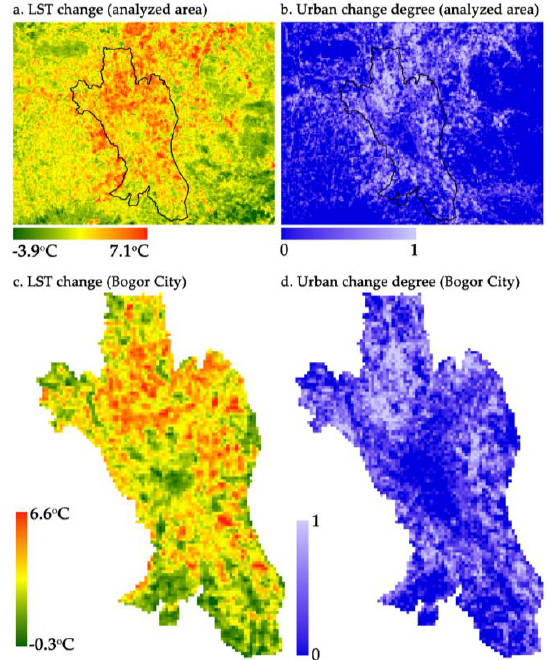
Figure 13. LST change and urban change degree. ( a ) LST change between 1990 and 2017, ( b ) Status of urban change (from non-urban to urban), ( c ) LST change between 1990 and 2017 in Bogor City, and ( d ) Status of urban change (from non-urban to urban) in Bogor City. One pixel is 150 m × 150 m (averaging value from 5 × 5 pixels of original image resolution 30 m).